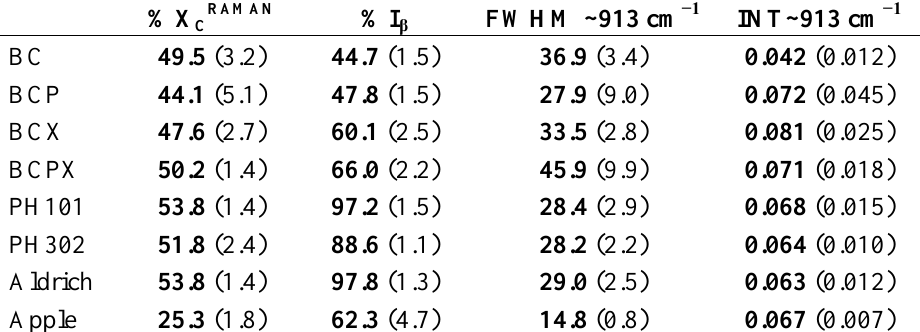
Table 2. Calculated values of cellulose crystallinity, percentage content of cellulose I FWHM (full width at half maximum) and intensity of Raman peak around 913 cm −1 for bacterial, microcrystalline and apple celluloses. In parenthesis standard